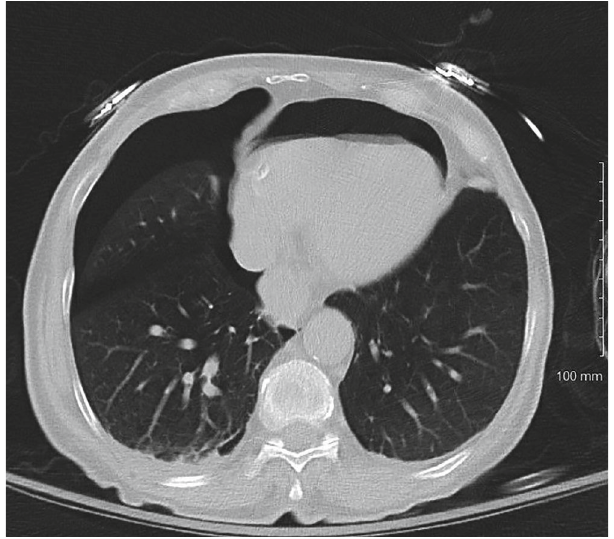
Figure 3: Noncontrast chest CT scan showing pneumopericardium, pneumothorax, and pericardial e ff usion.